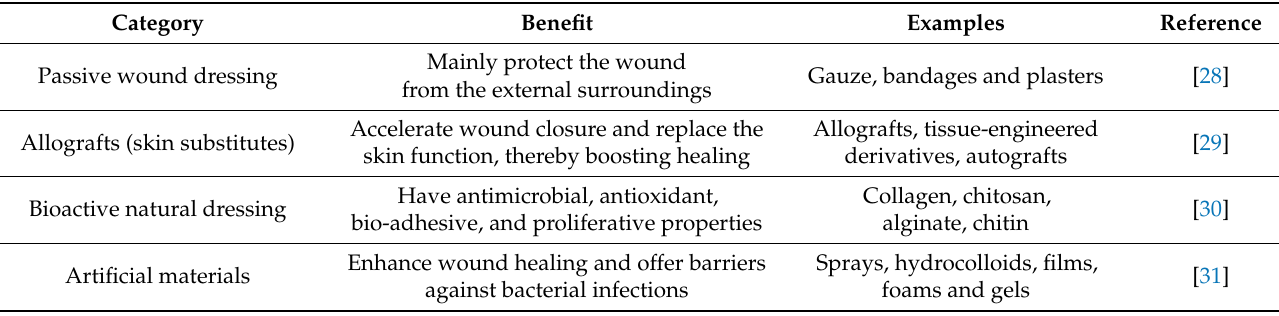
Table 1. Types of wound dressings.